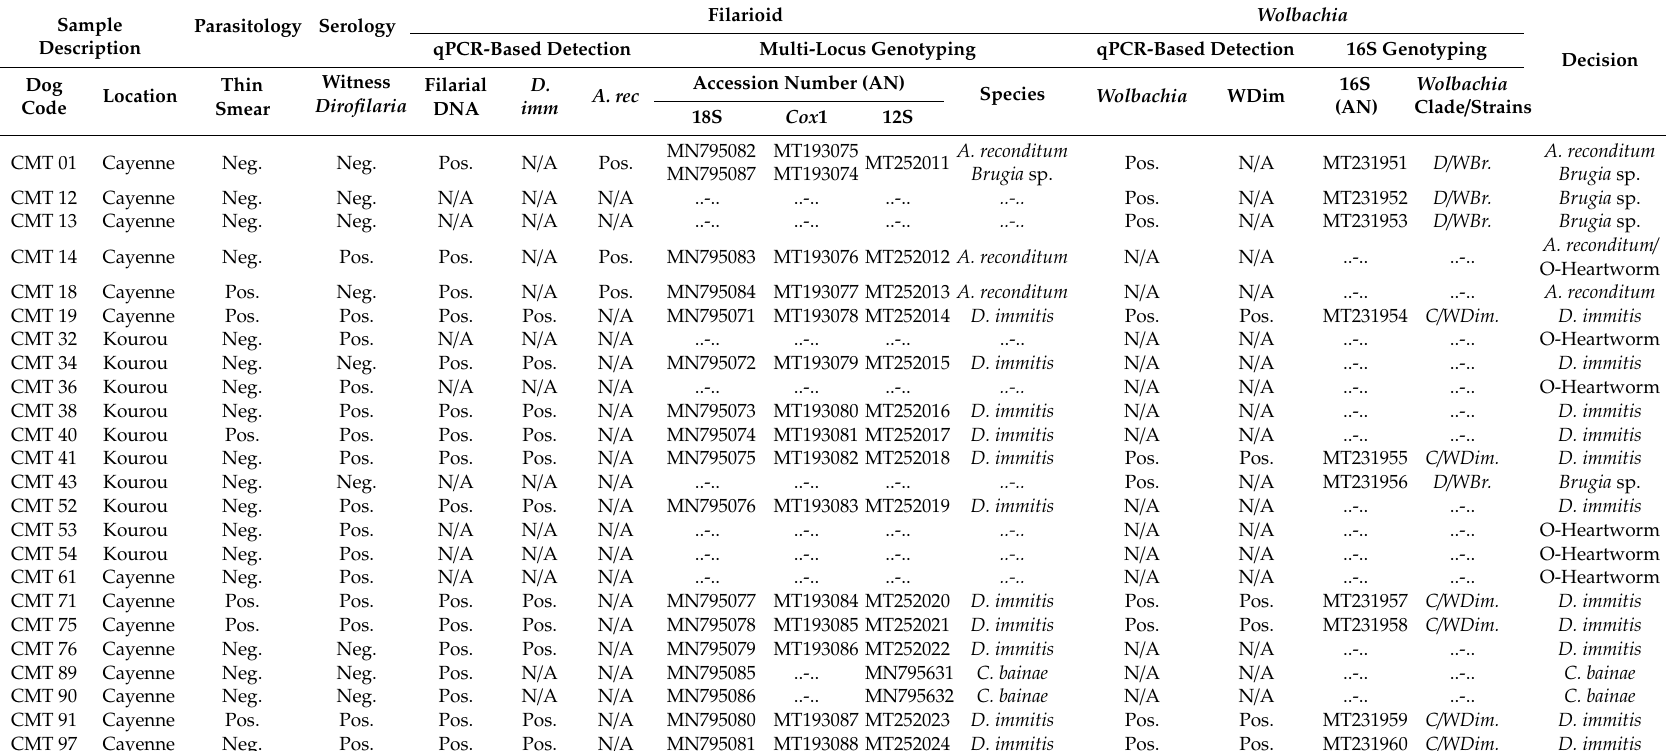
Table 2. Results of dogs positive for at least one assays (parasitologic, serologic and molecular